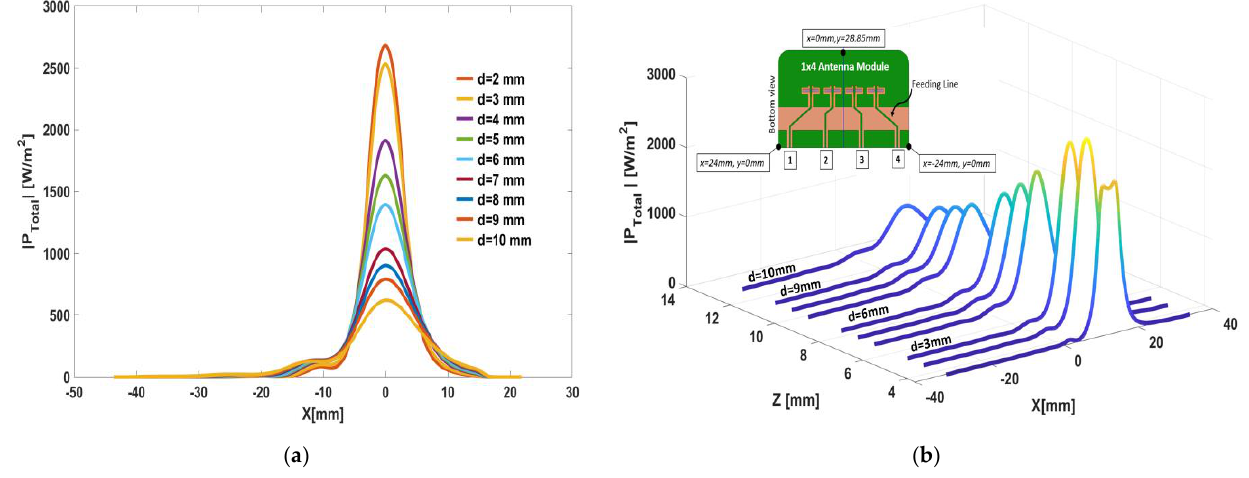
Figure 9. Extracted power-density ( a ), ( b ) as function of probing distance.